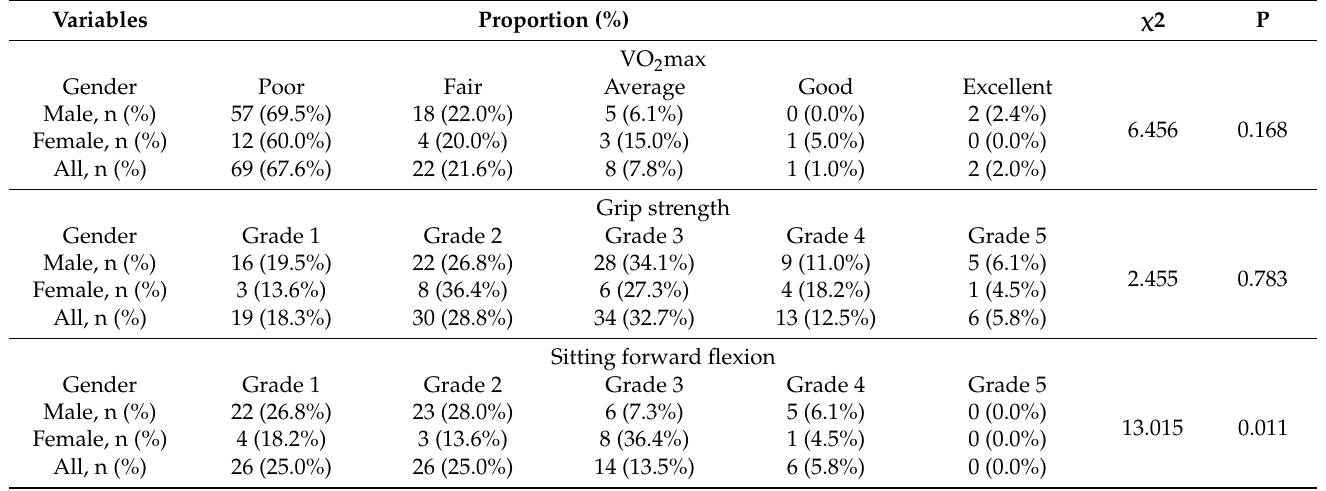
Table 2. Grades of health-related fitness in NAFLD patients (N = 104).